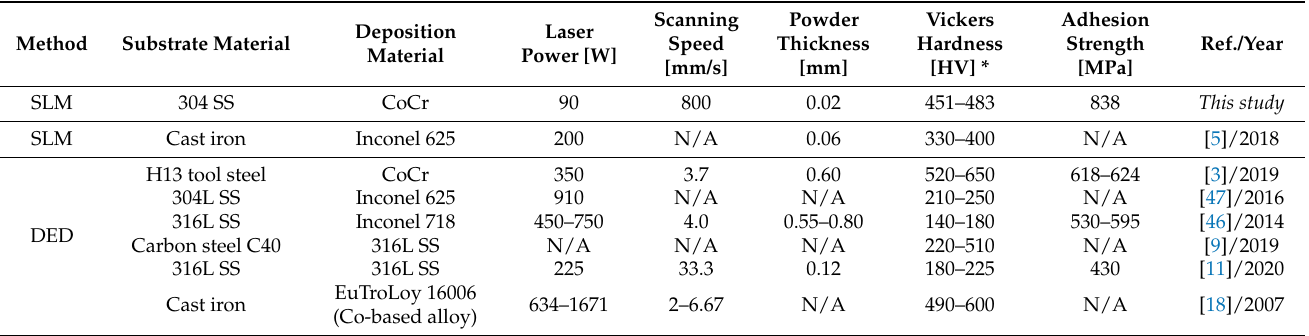
Table 6. Comparison of the adhesion strength and hardness obtained using different manufacturing methods to repair steel